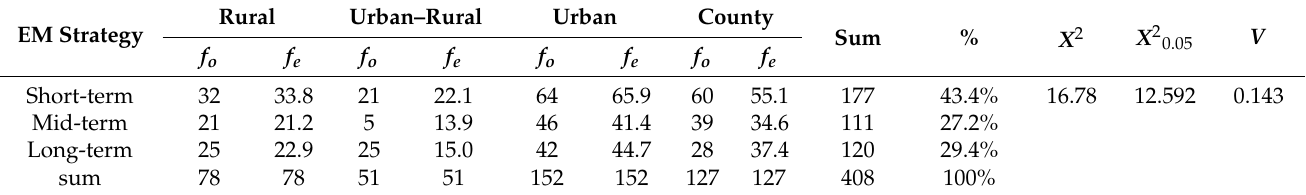
Table 3. Influence of the type of community (urban–rural) on the range of the